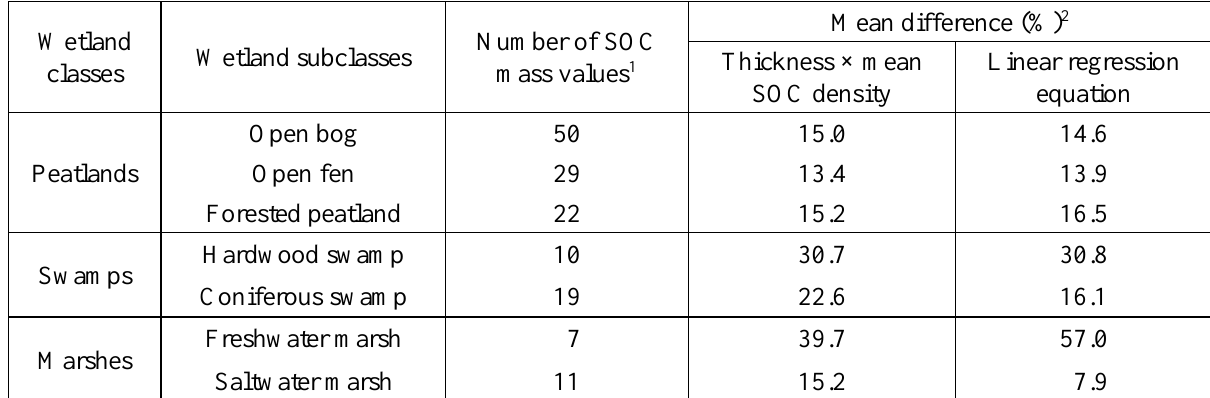
Table 2. Precision of SOC mass estimates from measurements of peat/soil thickness in the different wetland subclasses using the two calculation approaches.